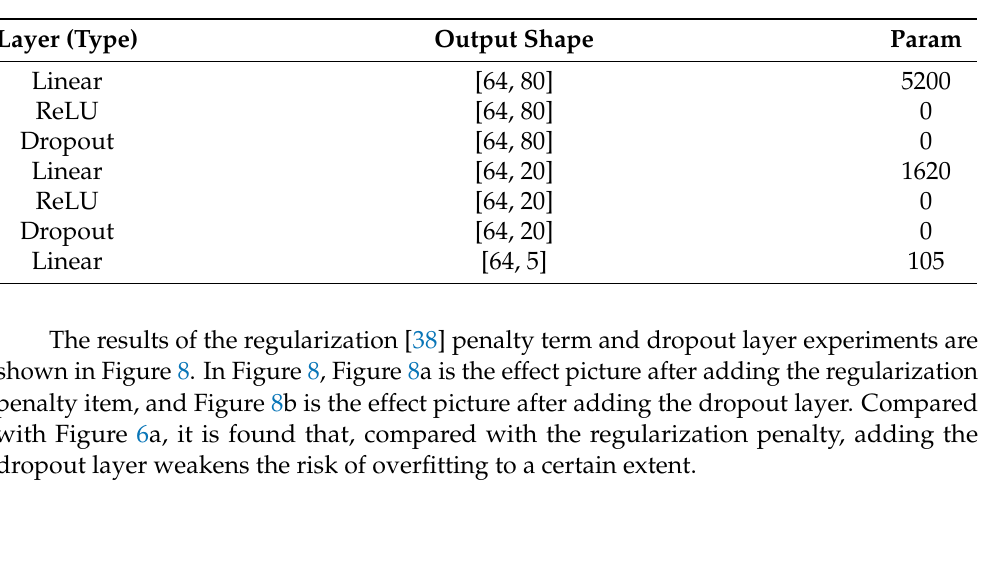
Table 3. CVAEWD hidden parameter variable classifier parameters and